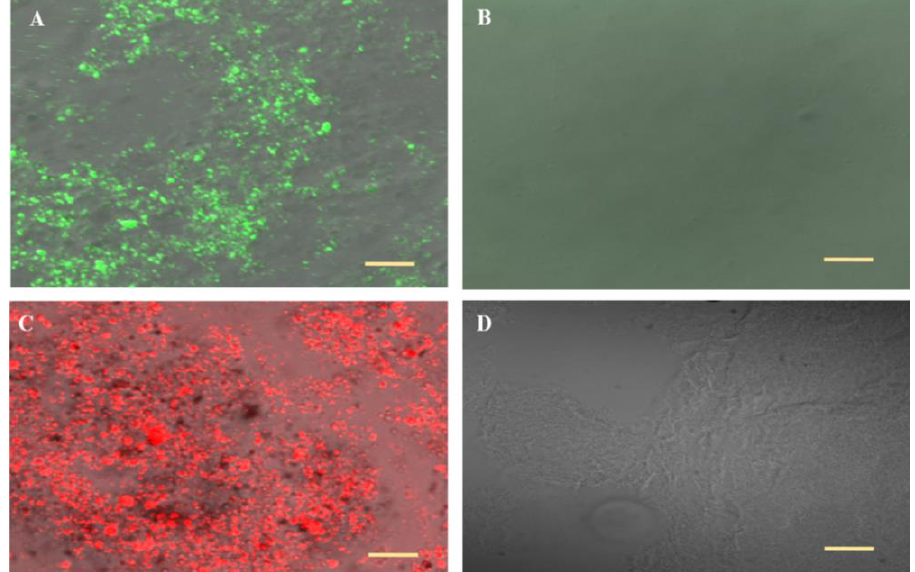
Figure 2. Representative CLS micrographs for ( A ) Nanovesicular carrier containing FITC, ( B ) a hydro-glycolic solution lacking the phospholipid containing FITC, ( C ) Nanovesicular carrier containing R6G and ( D ) a hydro-glycolic solution lacking the phospholipid containing R6G. Olympus Fluoview 300, Tokyo, Japan, Lens × 60 (Bar = 10 μm).